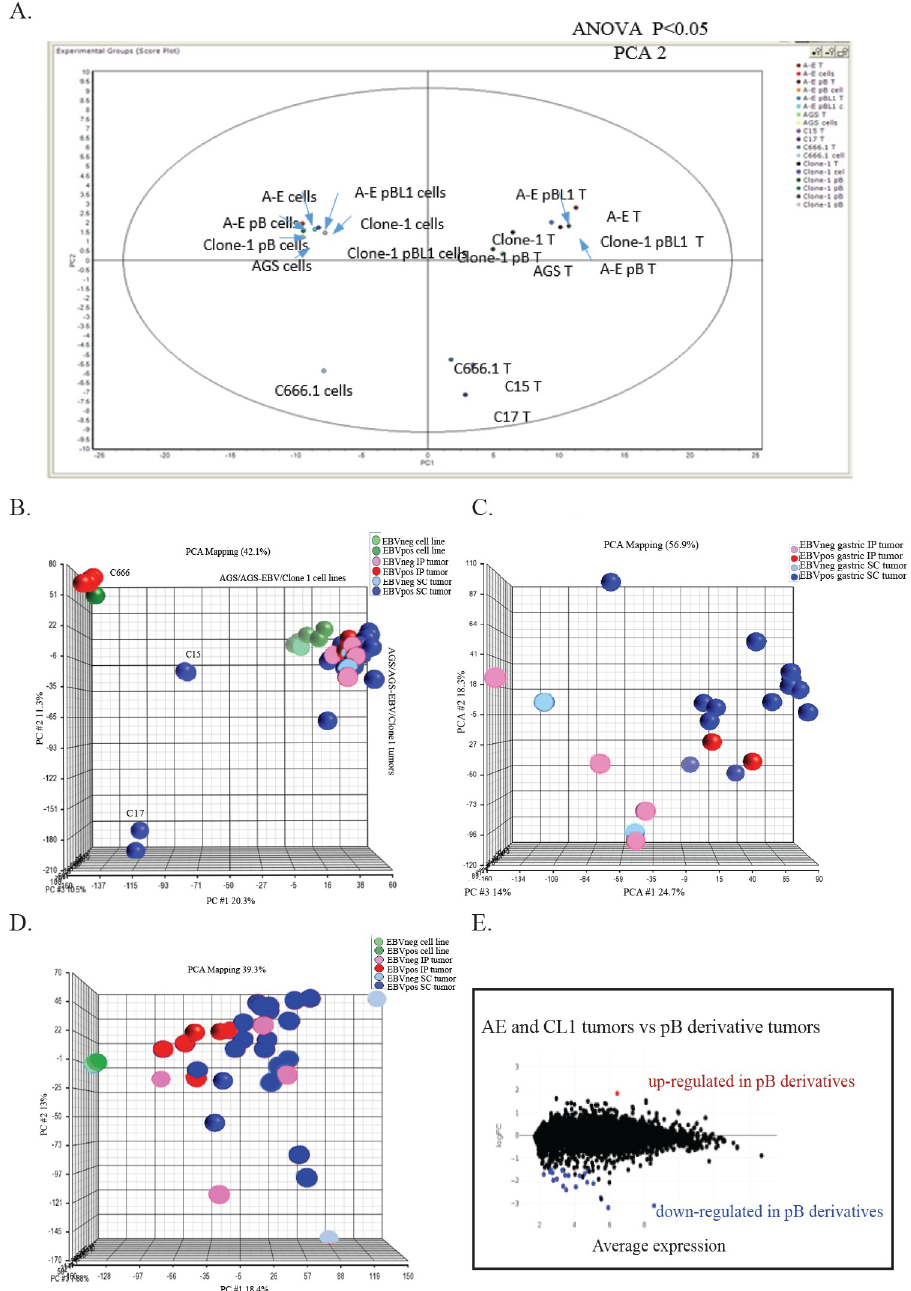
Fig 2. Principal component analysis based on 2D DIGE and RNA Seq analysis of the cell lines and tumors. (A) Principal component analysis of variation between proteins detected by 2D DIGE from the AGS, AGS-EBV, Clone1, pB derivatives, C666.1, and xenografts C15 and C17 cell lines and tumors. T represents tumors. (B) Principal component analysis based on variation between all expressed human transcripts from the AGS, AGS-EBV, Clone1, pB derivatives, C666.1, and xenografts C15 and C17 cell lines and tumors. (C) Principal component analysis based on variation between all expressed human transcripts from the AGS, AGS-EBV, Clone1, and pB derivatives gastric tumors. (D) Principal component analysis based on variation between all expressed mouse transcripts from the AGS, AGS-EBV, Clone1, and pB derivatives, C666.1, and xenografts C15 and C17 tumors. (E) Volcano plot of human gene expression of the pBabe derivative tumors vs the original cell line tumors. The few blue dots denote the significantly downregulated genes in the pBabe derivative tumors compared to the original cell line tumors and the red dots denote the significantly up regulated genes in the pBabe derivative tumors compared to the original cell line